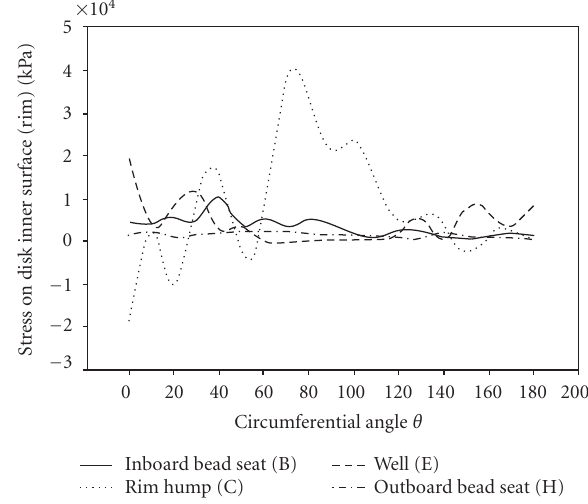
Figure 13: Influence of inflation pressure on the maximum princi- pal stress distribution at the inboard bead seat.